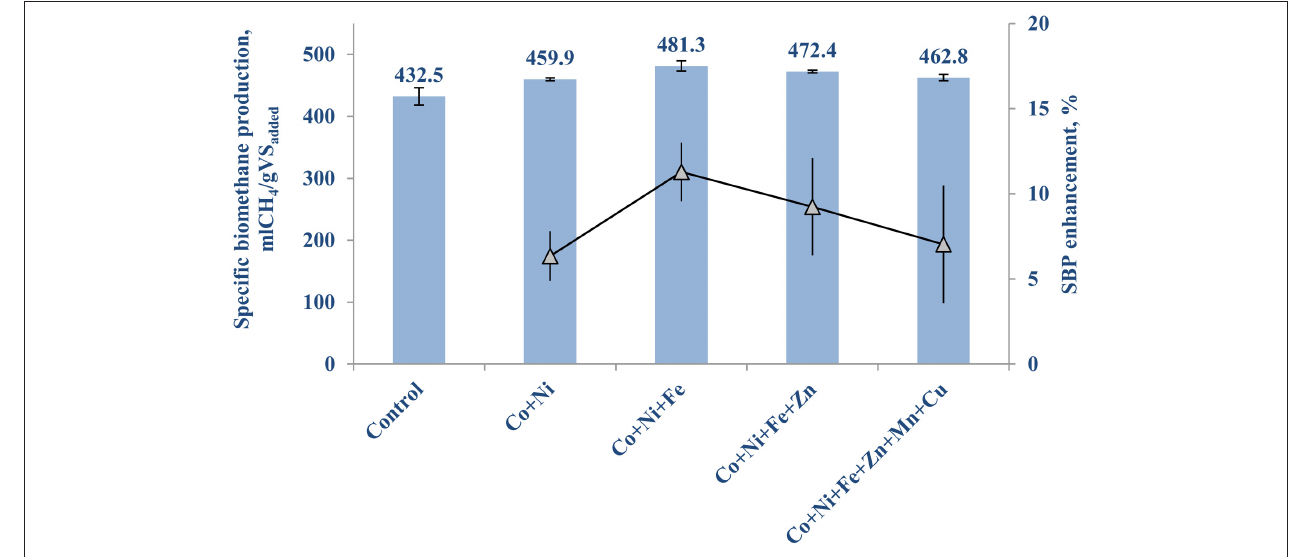
FIGURE 2 | Effect of TE (II) on the SBP of